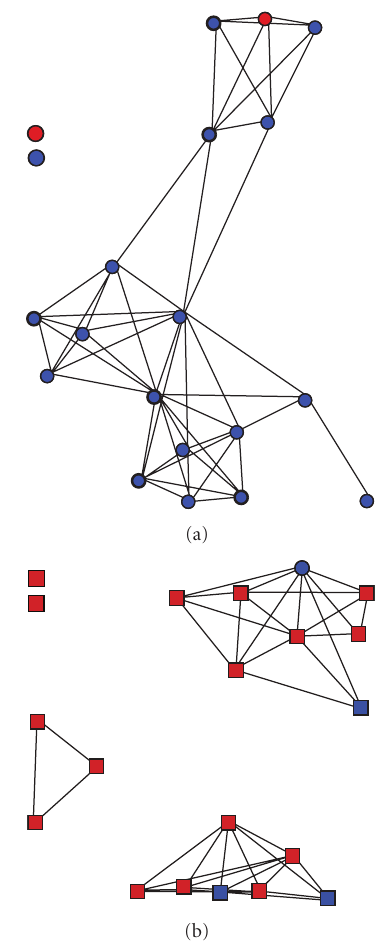
Figure 1: Graphical example of the relationship between social network characteristics and discussion of HIV with network